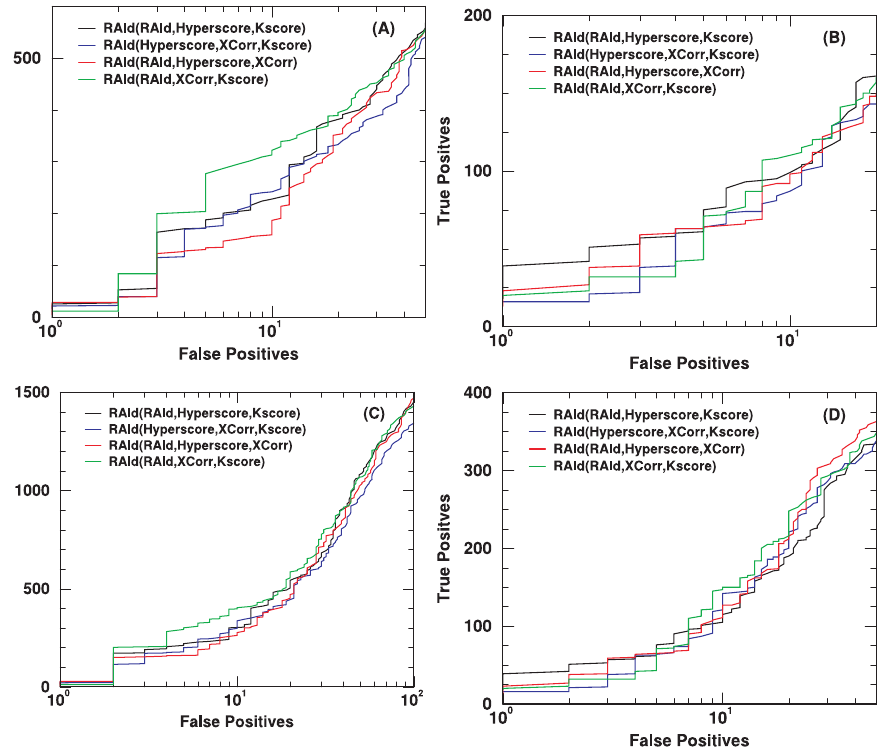
Figure 8. Illustration of RAId_aPS performance when combining three different scoring functions. Panel (A) shows the results from the profile data (NHLBI data set [4]), while panel (B) exhibits the results from the centroid data (A1–A4 of the ISB data set [28]). Panel (C) shows the results from the profile data but keeping only the best hit per spectrum, while panel (D) exhibits the results from the centroid data but keeping only the best hit per spectrum. doi:10.1371/journal.pone.0015438.g008 PLoS ONE |